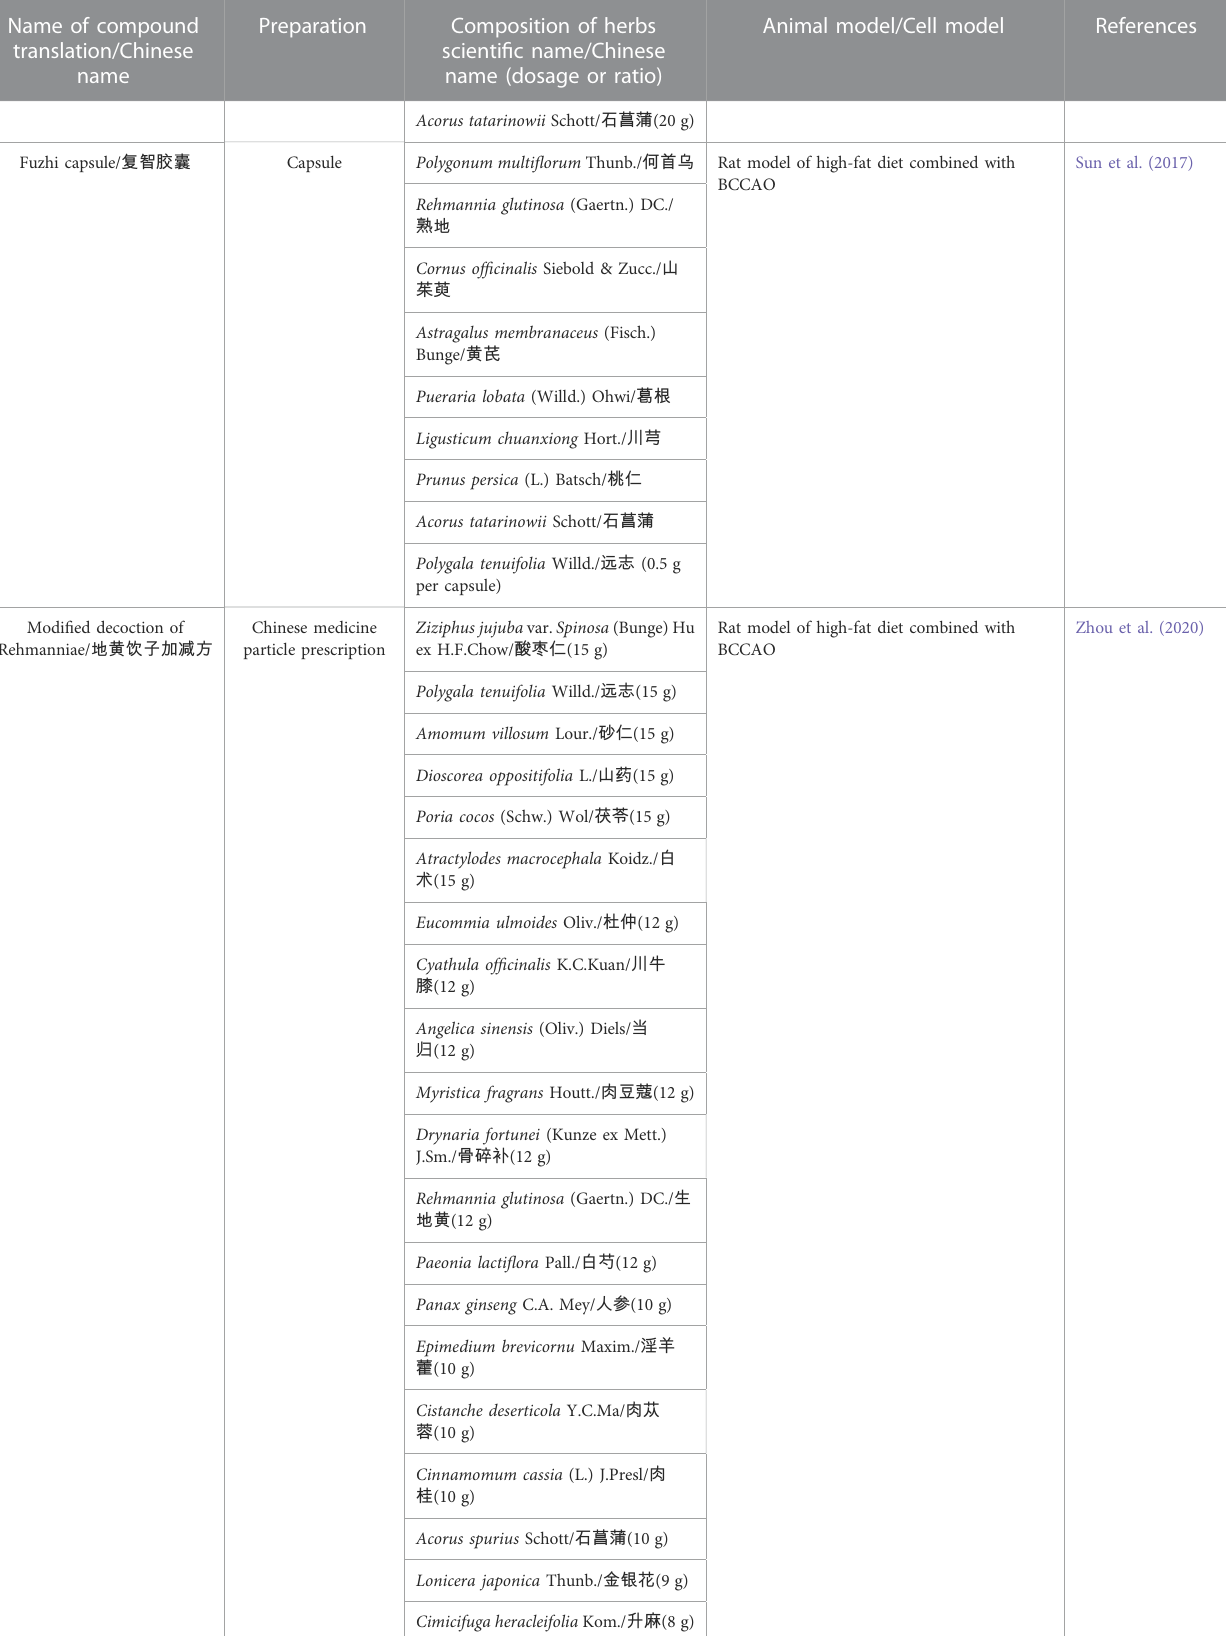
TABLE 1 ( Continued ) Composition of Chinese herbal compounds targeting mitochondria after